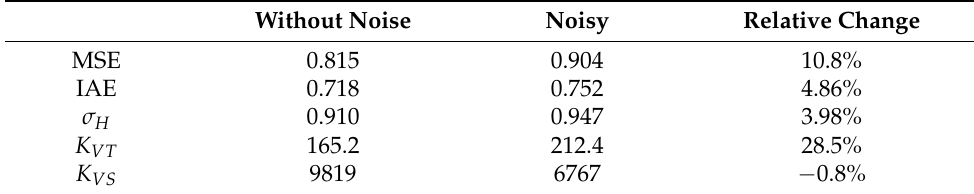
Table 16. G 4 ( s ) CPA indexes.